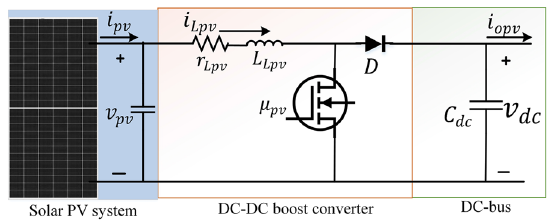
Fig. 3 The DBC equivalent circuit for the solar PV system